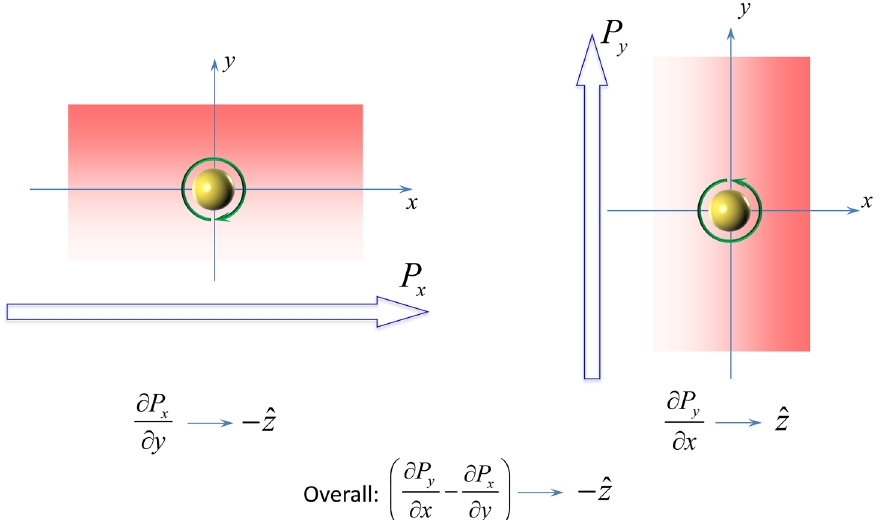
Figure 4: Classical phenomenological model analogous to fluid dynamics employed to demonstrate the relationship between transverse torqueandenergyflow:(a)anenergy fl owpropagatingalongthe + x -directionwithgraduallyincreasingmagnitudeinthe y -directionwillcause the immersed particle to rotate clockwise; (b) an energy fl ow propagating along the + y -direction with nonuniformity in the x -direction causes the same particle to rotate anticlockwise. The overall spinning effect on the particle is determined by factor ( ∂ P y / ∂ x − ∂ P x / ∂ y ) ̂ z